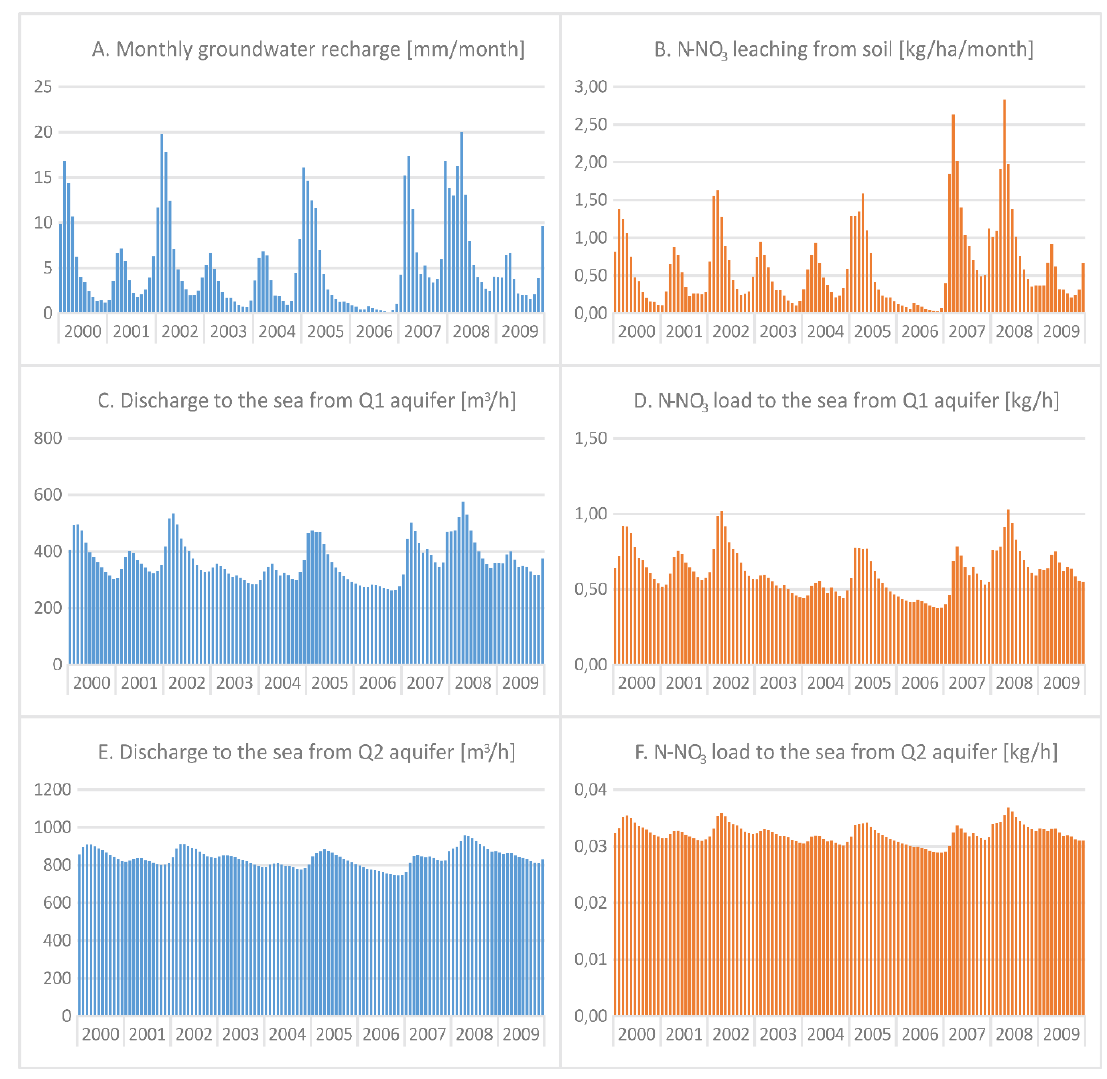
Figure 5. Average monthly values of selected groundwater budget components and N-NO 3 loads for scenario S2 (winter wheat).